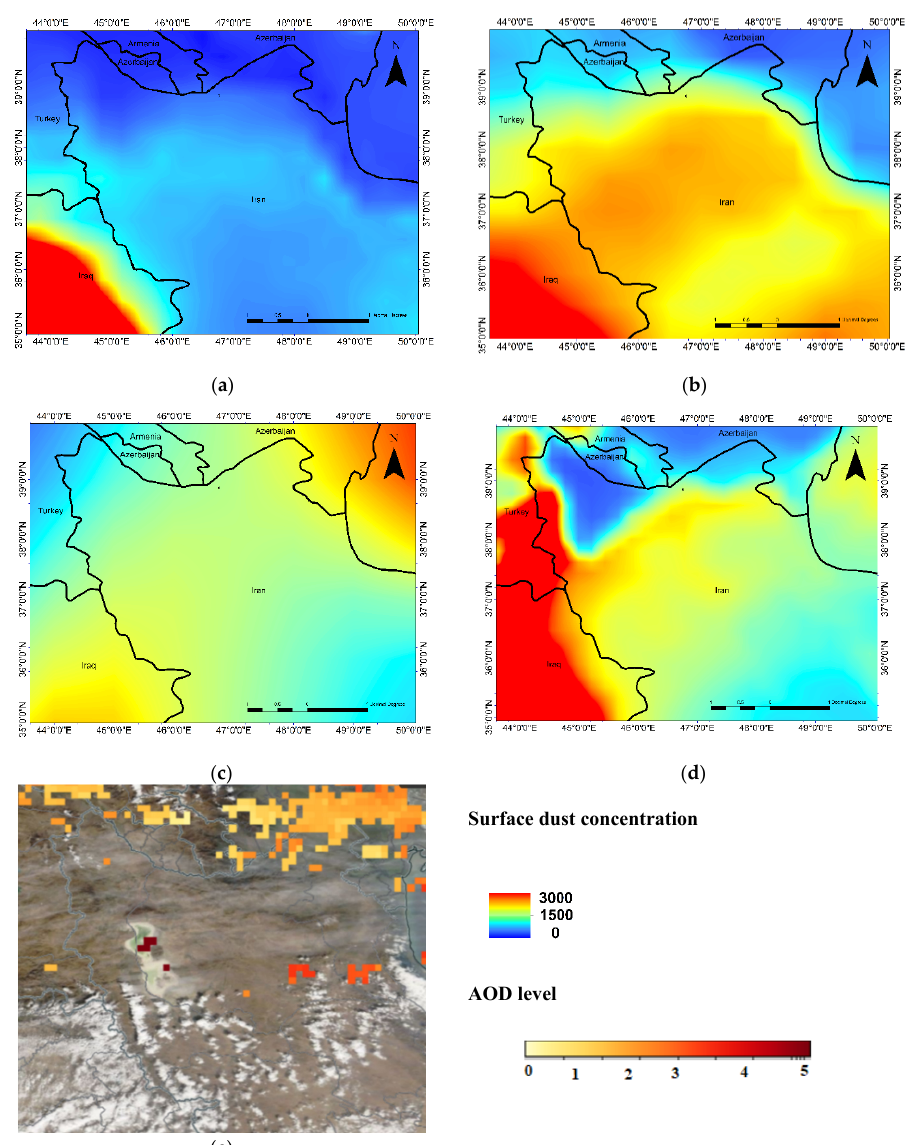
Figure 10. The surface dust concentration (µg/m 3 ) of the four models’ output at 09 UTC on 27 October 2017 and Aqua satellite (overpasses 09 UTC) with AOD (0 to 5). ( a ) DREAM_MACC; ( b ) DREAMABOL; ( c ) NCEP_NGAC; ( d ) NOAA/WRF-Chem; ( e ) MODIS AOD.